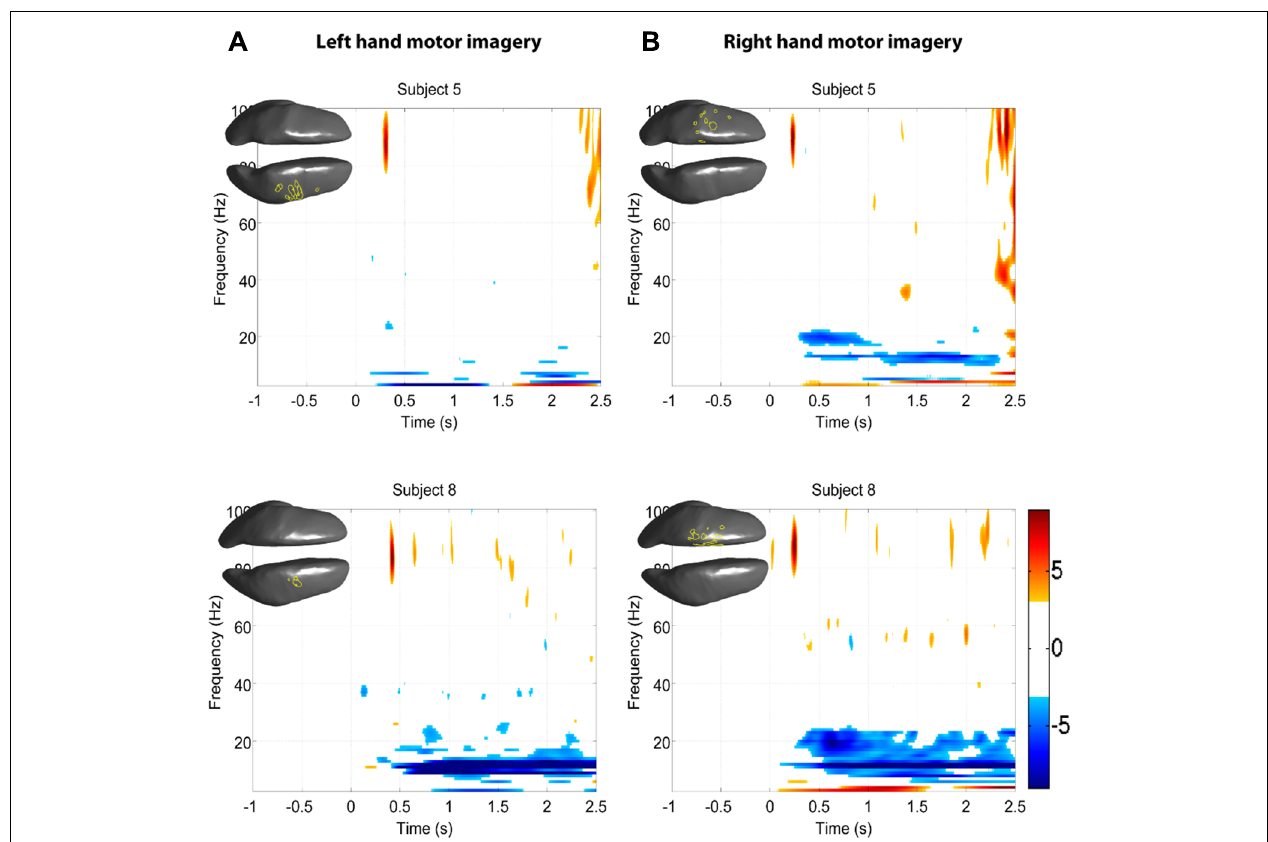
FIGURE 9 | Z -score time-frequency maps for subjects 5 and 8 for the cortical regions indicated on the cortical surface displayed in the upper left corner. The maps show that subjects have significant HG increases post-cue in a narrow band. (A) Time-frequency maps during left hand motor imagery. (B) Time-frequency maps during right hand motor